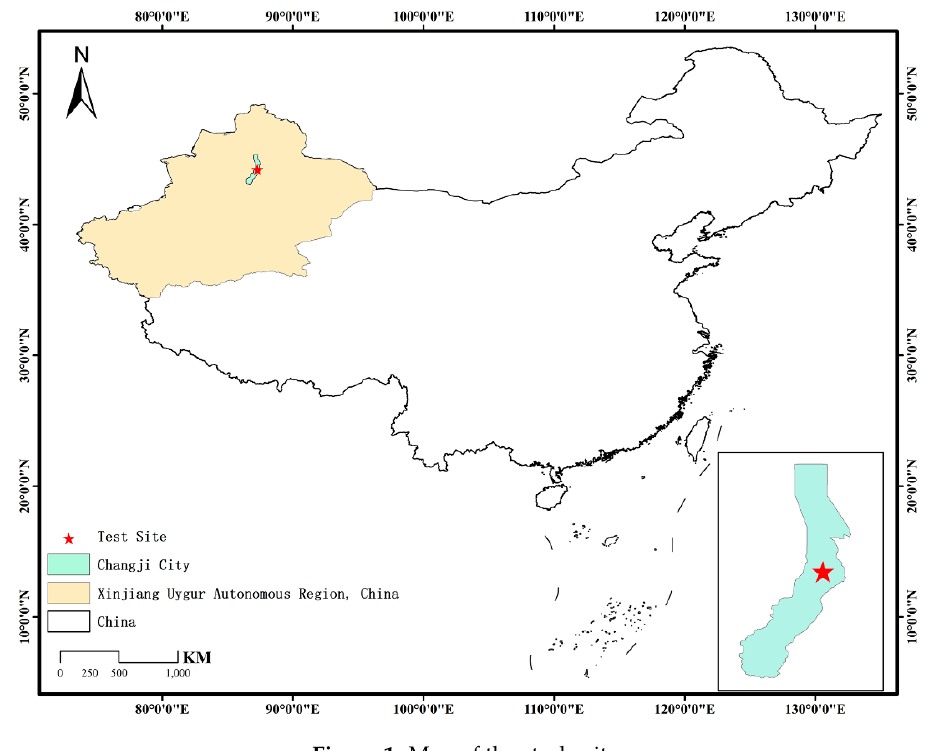
Figure 1. Map of the study site. Table 1. Basic physiochemical characteristics of the study site soils by soil depth (mean ± standard deviation).